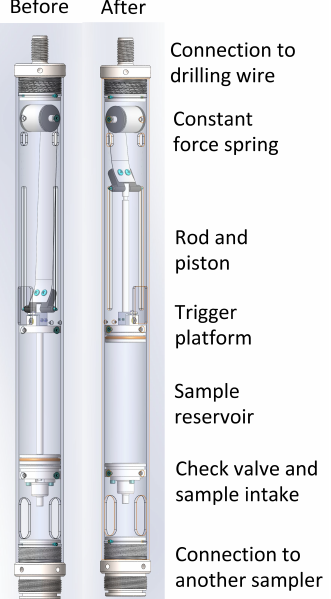
Figure 1. Cross section of a single module of the MTFS highlight- ing its primary components before the sampler is triggered and after.